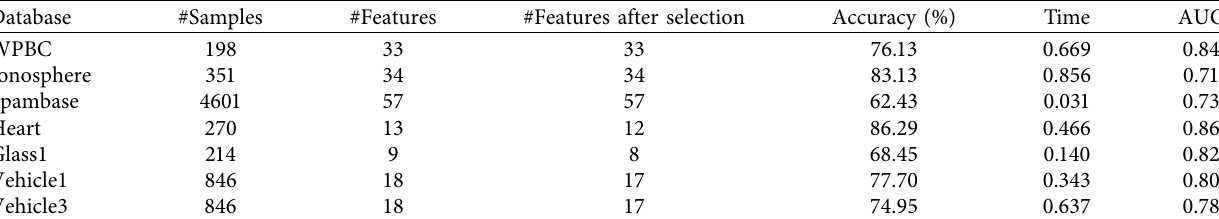
Table 5: Results for ℓ